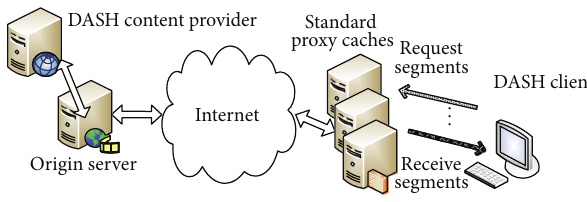
Figure 1: Typical DASH system